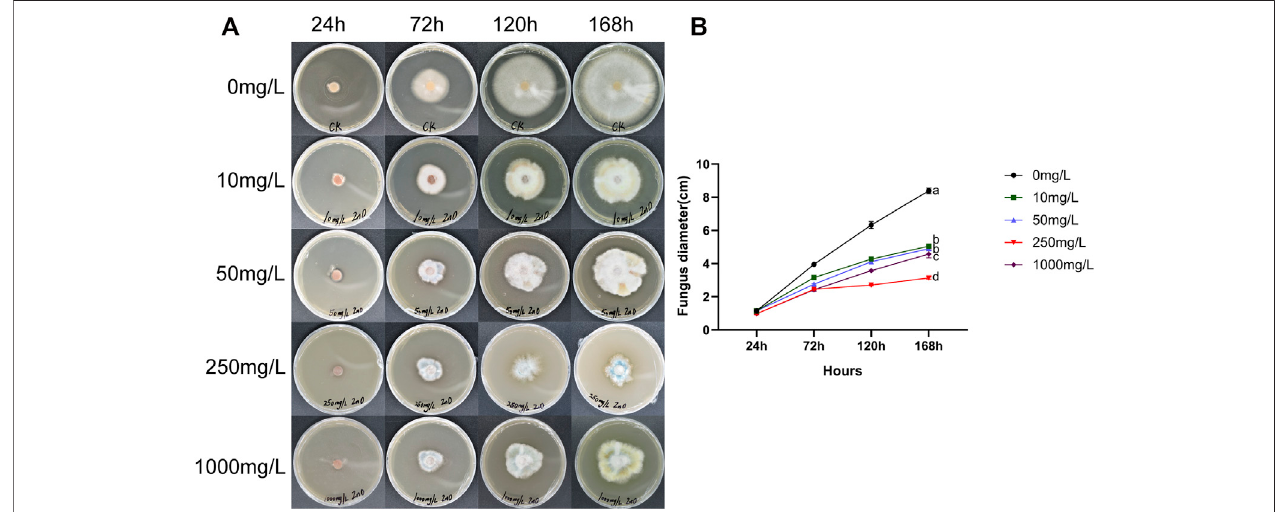
FIGURE 1 | After adding ZnO-NPs to PDA medium, the inhibitory effect on the growth of F. proliferatum . (A) Growth of F. proliferatum at 24, 72, 120, 168 h after treatment with different concentrations of ZnO-NPs. (B) Diameter variation curve of F. proliferatum after treatment with different concentrations of ZnO-NPs. There is a signi fi cant difference between the mean values of different treatments using one-way ANOVA and Duncan ’ s multiple range test ( p < 0.05). Error bars indicate ± S.E. ( n = 3).